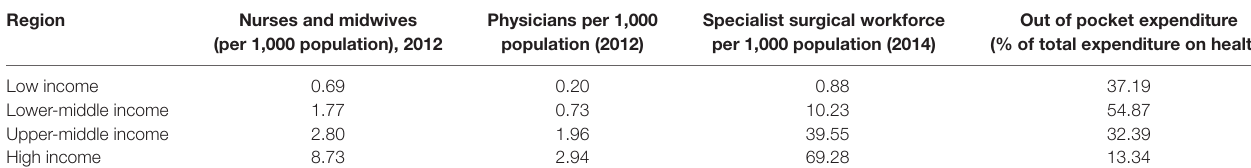
TAbLe 2 | Resources for health care by income region (8). Region